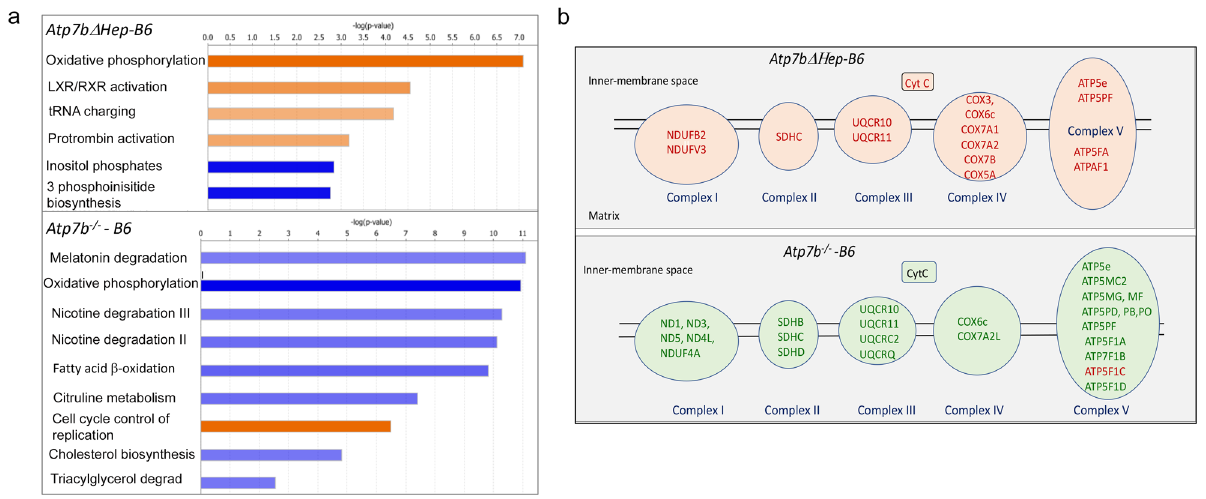
Figure 7. Comparison of the altered pathways in Atp7b ΔHep - B6 and Atp7b -/– B6 livers using Ingenuity Pathway Analysis (IPA). ( a ) The most significantly changed pathways (|Z| score > 2.5 for Atp7b -/– B6 animals and > 2.3 for Atp7b ΔHep - B6 pathways. The data were generated using samples analyzed within the same mass-spectrometry run; n = 3 per each genotype. Orange color indicates the upregulated pathways and blue color – down-regulated pathways. The complete list of affected pathways is given in Suppl Table 4 and Suppl Table 5. ( b ) Components of the respiratory chain in mitochondria that are significantly changed in response to Cu accumulation in Atp7b ΔHep - B6 and Atp7b -/– B6 mice. Upregulated proteins are labeled in red, down-regulated proteins are in green. Data generated and visualized using IPA (https ://digit alins ights .qiage n.com/produ cts-overv iew/disco very-insig hts-portf olio/analy sis-and-visua lizat ion/qiage